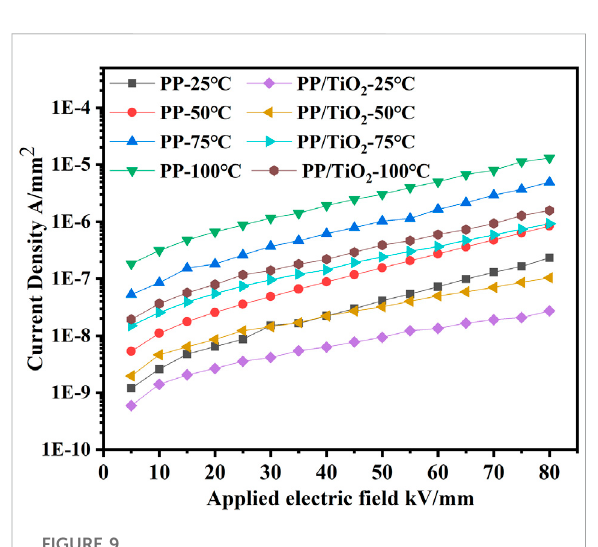
FIGURE 9 Current density at different temperatures and electric fi elds.